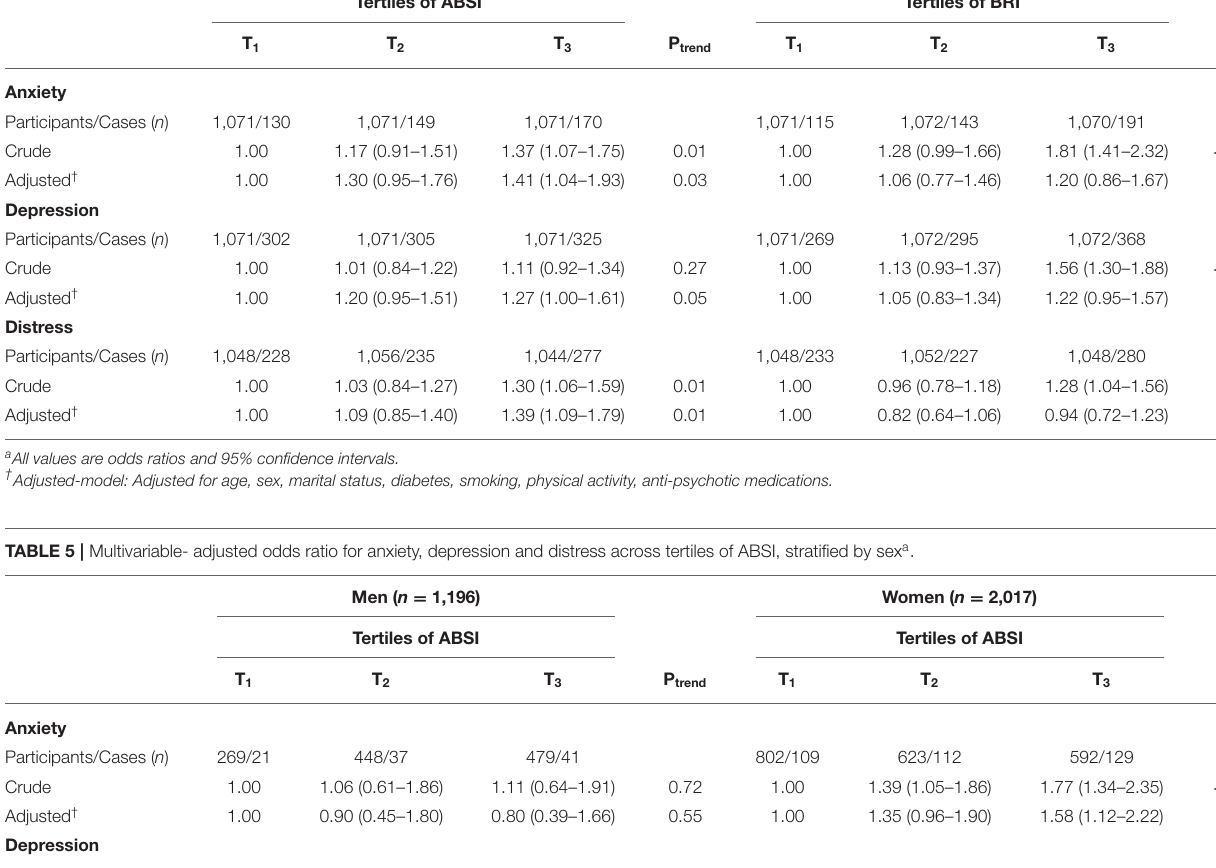
TABLE 4 | Multivariable- adjusted odds ratio for anxiety, depression, and distress across tertiles of ABSI and BRI ( n = 3,213) a . Tertiles of ABSI Tertiles of BRI